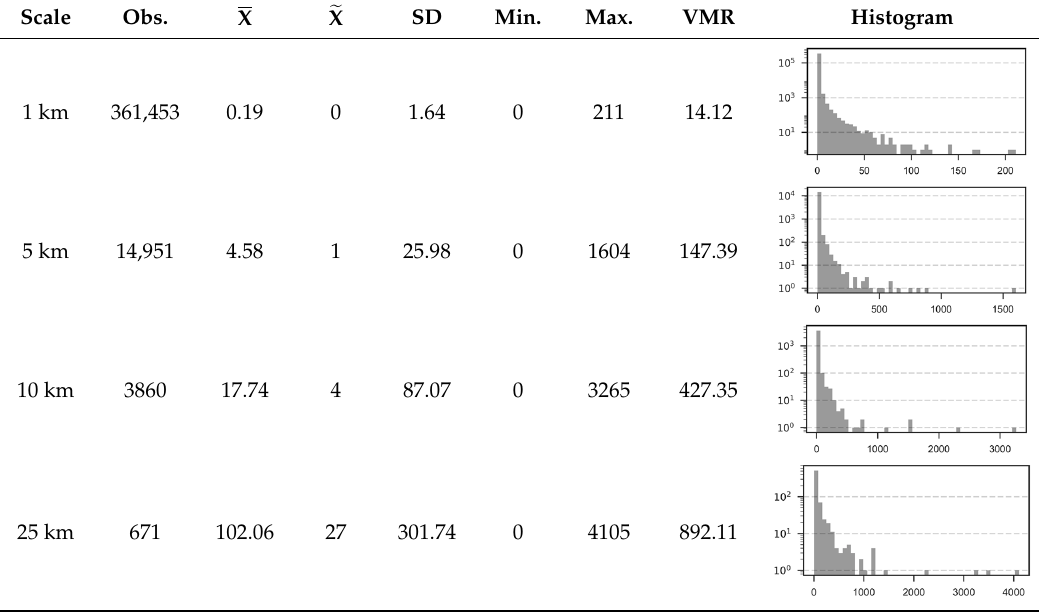
Figure 1 maps the gridded distribution of software firms in Germany. An exemplary focus map